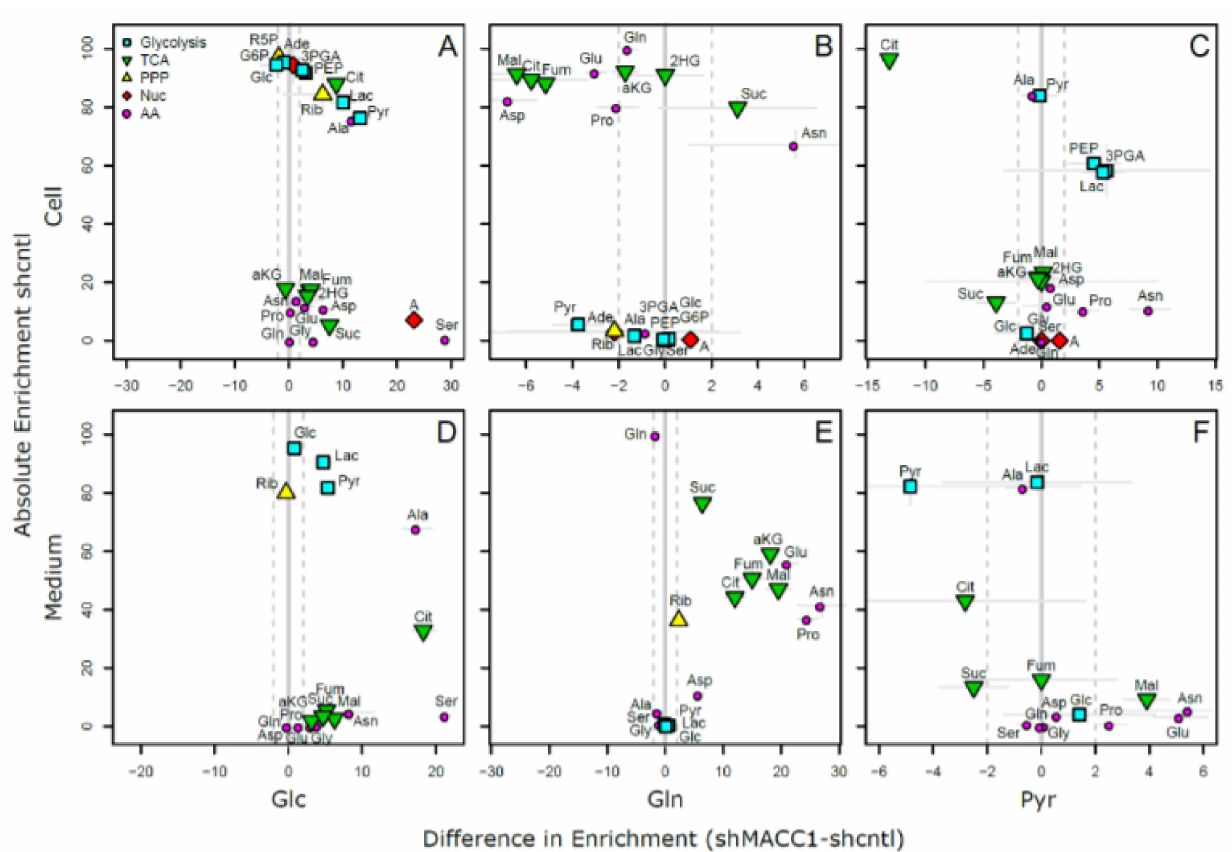
Figure 7. Metabolite labeling differences between shMACC1 and shcntl cells. Absolute labeling compared to labeling difference between shcntl and shMACC1 for intracellular ( A – C, top panel) and medium ( D – F , bottom panel) levels using Glc ( A , D ), Gln ( B , E ) and Pyr ( C , F ) as 13 C tracer. Metabolites further away from the center (grey line) of a subplot are differentially labeled. Dashed grey lines indicate a 2% window of uncertainty, i.e., the technical reproducibility of determining an enrichment. Individual uncertainties generally depend on the compound abundance and stability and standard deviations are indicated per metabolite as thin grey lines. (PPP: Pentose Phosphate Pathway, TCA: Tricarboxylic Acid Cycle, Nuc: Nucleic Acid Biosynthesis, AA: Amino acids, Glc: Glucose, G6P: Glucose-6-phosphate, 3PGA: Glyceric acid-3-phosphate, PEP: Phosphoenolpyruvic acid, Pyr: Pyruvic acid, Lac: Lactic acid, R5P: Ribose-5-phosphate, Rib: Ribose, Ade: Adenosine, alpha-, A: Adenine, Cit: Citric acid, aKG: Glutaric acid, 2-oxo-, 2HG: Glutaric acid, 2-hydroxy-, Suc: Succinic acid, Fum: Fumaric acid, Mal: Malic acid, Ala: Alanine, Pro: Proline, Asp: Aspartic acid, Asn: